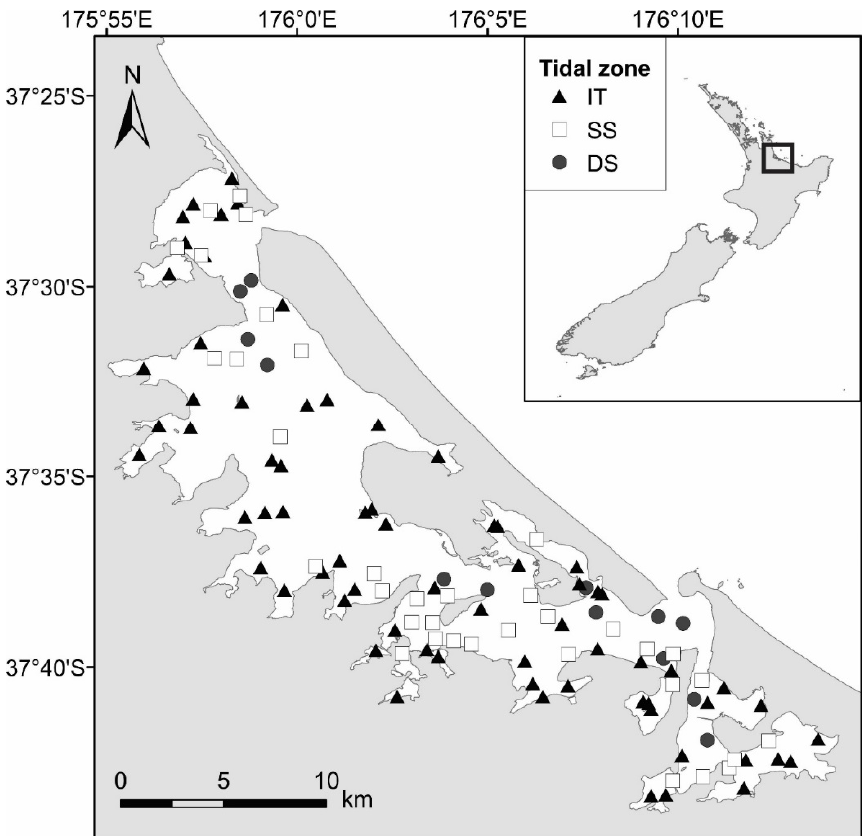
Figure 1. Location of Tauranga Harbor on the northeast coast of New Zealand (insert) and sample site locations within the harbor. The symbols indicate each site’s tidal zone assignation; intertidal (IT), shallow subtidal (SS), and deep subtidal (DS).